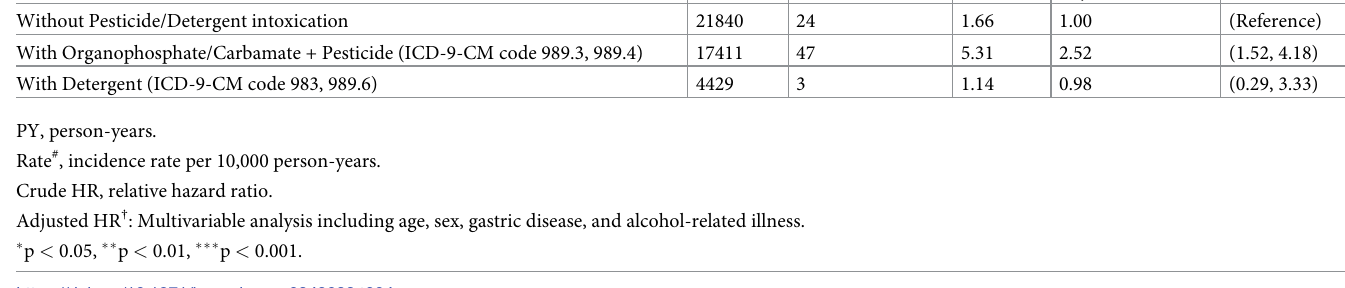
significant association exists between caustic ingestion and the risk of subsequent esophageal cancer. We defined conventional risk factors for esophageal cancer, such as age, sex, smoking, alcohol abuse, and gastric disease (such as achalasia and GERD), which were already well- established previously. In this 1-million-people cohort, 4,429 people were included in the detergent and corrosive intoxication group. The relative risk of esophageal cancer did not increase in patients with caustic agent and detergent poisoning compared with those without the poisoning after adjustment for these conventional risk factors. One of the reasons might be that our study included patients with exposure to detergents with less caustic characteristics. Detergents with acidic or alkaline characteristics are some of the most used toxic and corrosive Table 4. Incidence and adjusted hazard ratio of esophageal cancer between different entities of pesticide/detergent intoxication. Variable N Without Pesticide/Detergent